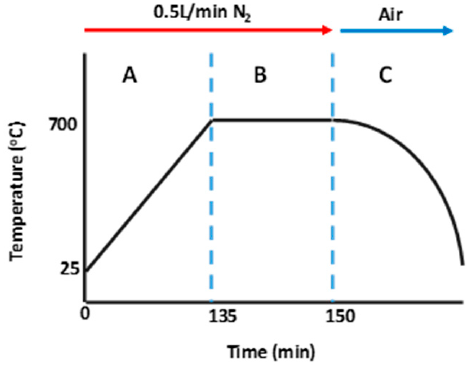
Figure 3. Schematic representation of the carbonization process used to prepare carbon derived from w-PET, w-PET/d-coal ash, and w-PET/d-coal samples. After completion of the carbonization, the yield of carbon derived from w-PET was determined. In direct carbonization, the final product was weighed using an analytical balance to the nearest 0.1 decimal and the residue yield of carbonized PET (c-PET) calculated using Equation